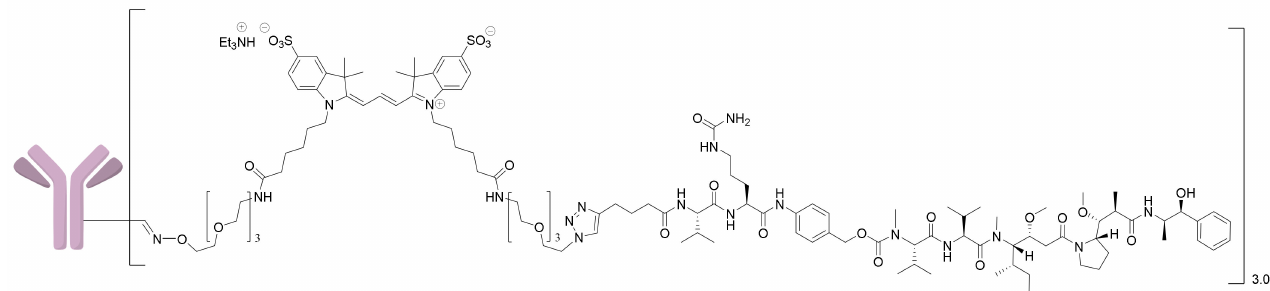
Figure 14. The structure of conjugate 32